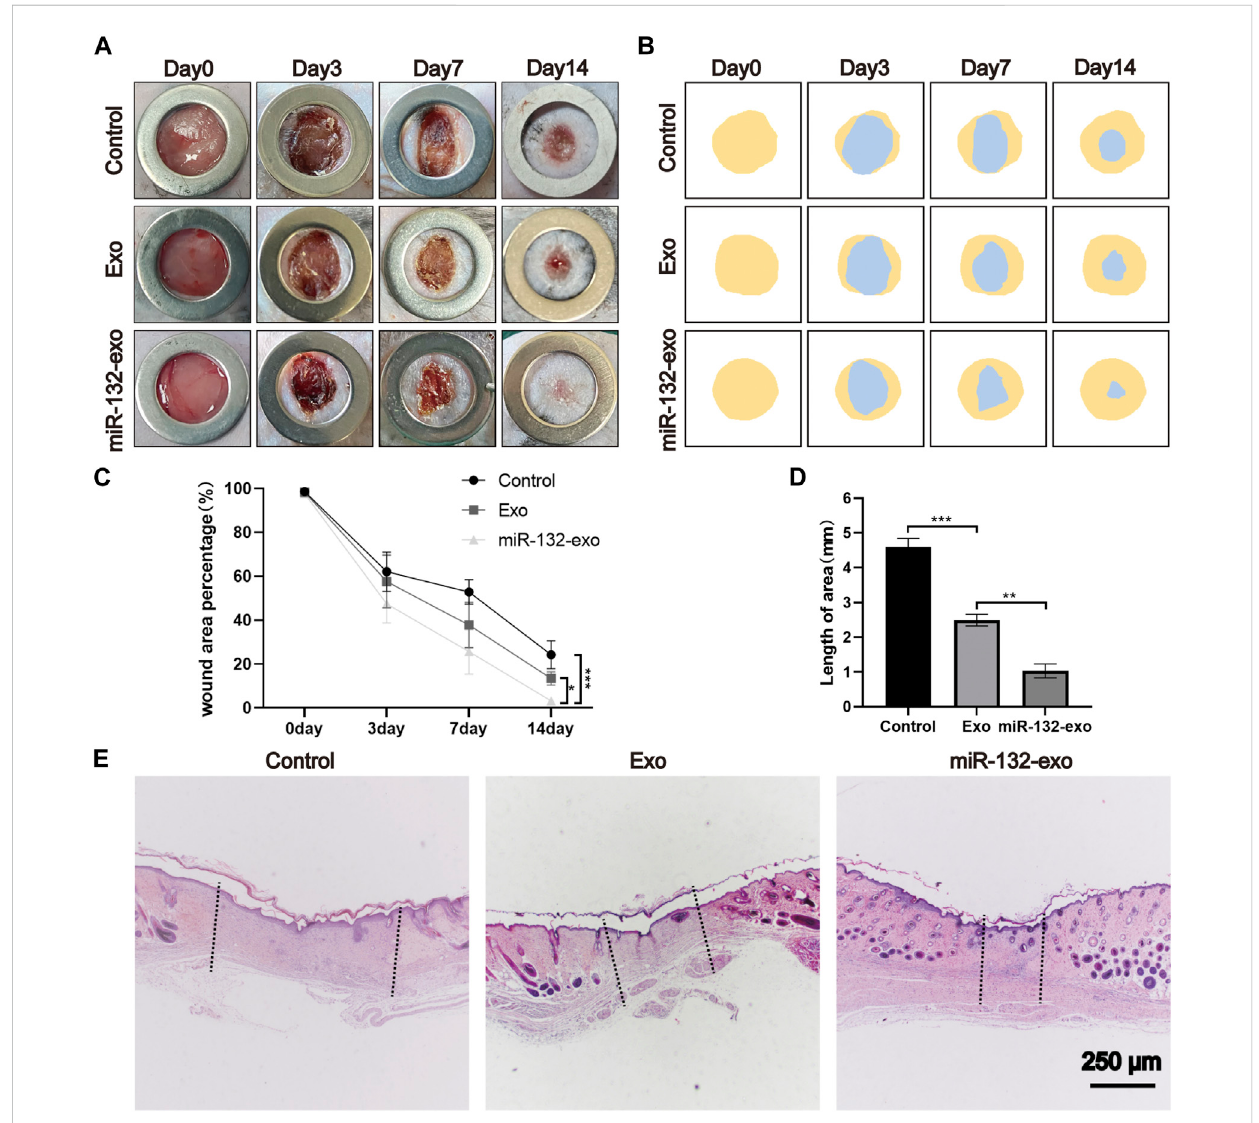
FIGURE 7 The miR-132-exo accelerated wound repair and regeneration in diabetic wounds. (A) Representative images of wound closure in a diabetic mouse model at the end of days 0, 3, 7, and 14 days following treatment with normal saline, exosomes, and miR-132-exo; (B) Schematic diagram of the wound area of each group; (C) Wound healing percentage of each groups at different time points; (D) Quanti fi cation of wound length assessed by H&E staining imagesineachgroup; (E) RepresentativeimagesofH&Estainingineachgrouponday14,scalebar=250 μ m* p < 0.05,** p < 0.01,*** p < 0.001,data are presented as the mean ± SD, n =